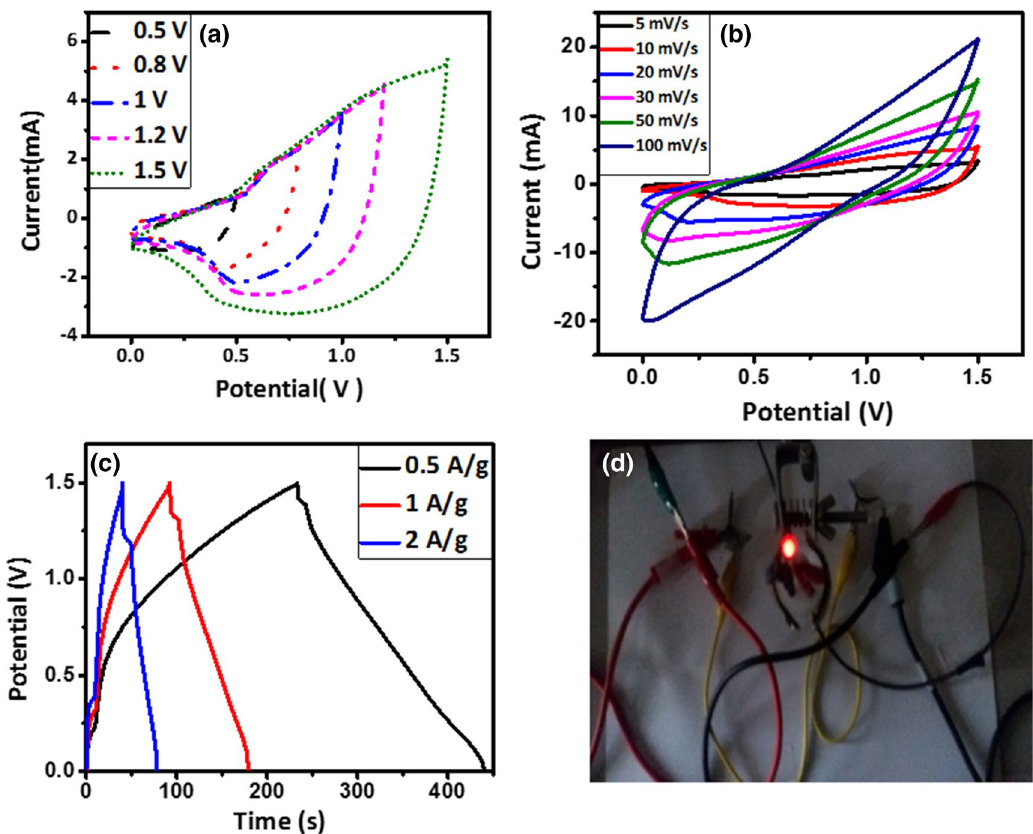
Figure 15. CV curves of the MnFe 2 O 4 //AC asymmetric device ( a ) at different potential windows at 10 mV/s and ( b ) at different scan rates. ( c ) GCD curves of the device at different current densities. ( d ) A picture of the assembled asymmetric supercapacitor lighting up a red